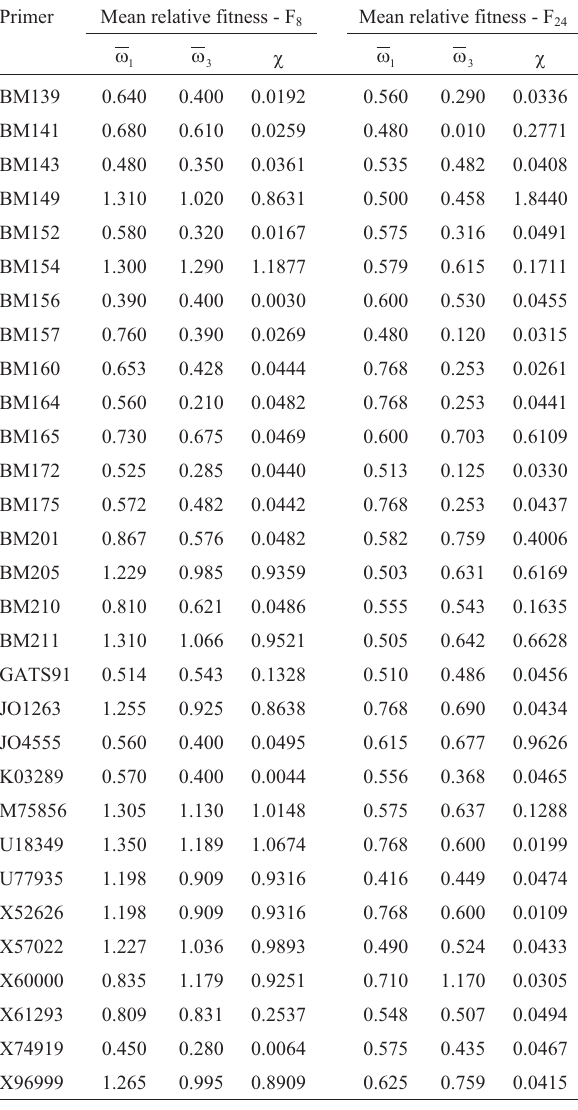
Table 4 - Estimates per locus of the coefficients of mean relative fitness (